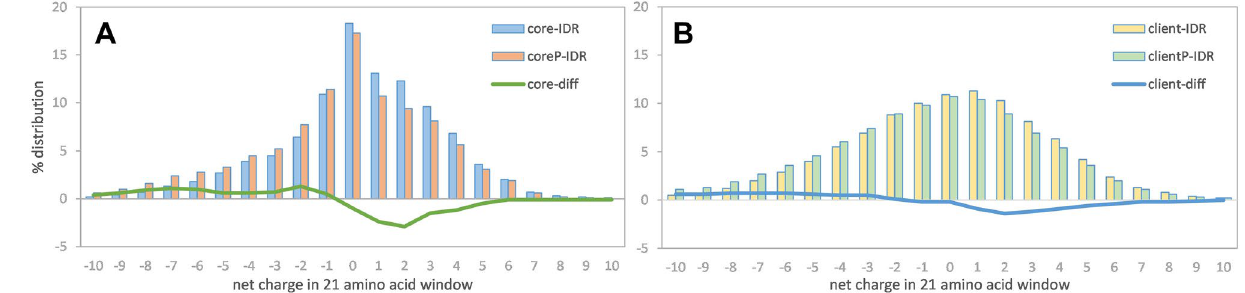
Figure 3. Core (panel A) and client (panel B) net charge distributions, and phosphorylated counterparts (denoted P), are calculated from overlapping 21 amino acid windows within predicted IDRs. For each of core and client proteins, the difference (phosphorylated—unphosphorylated) is also shown, as a line plot. For simplicity, the net charge in each window is shown on the x-axis. In terms of net charge per amino acid, the displayed values range from a minimum of − 0.476 to a maximum of